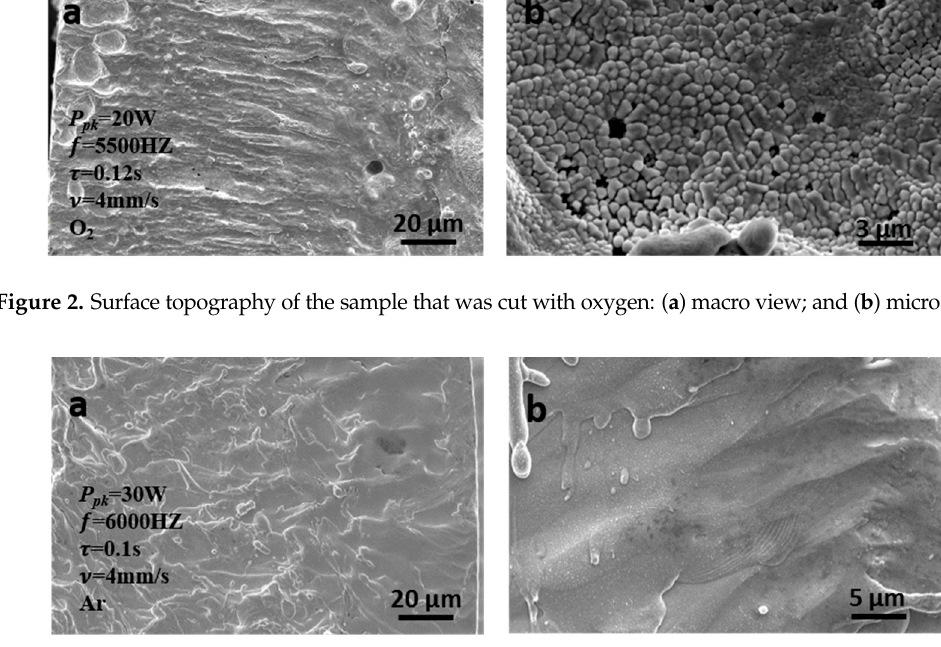
Table 4. Chemical composition on the oxygen cuts surface.